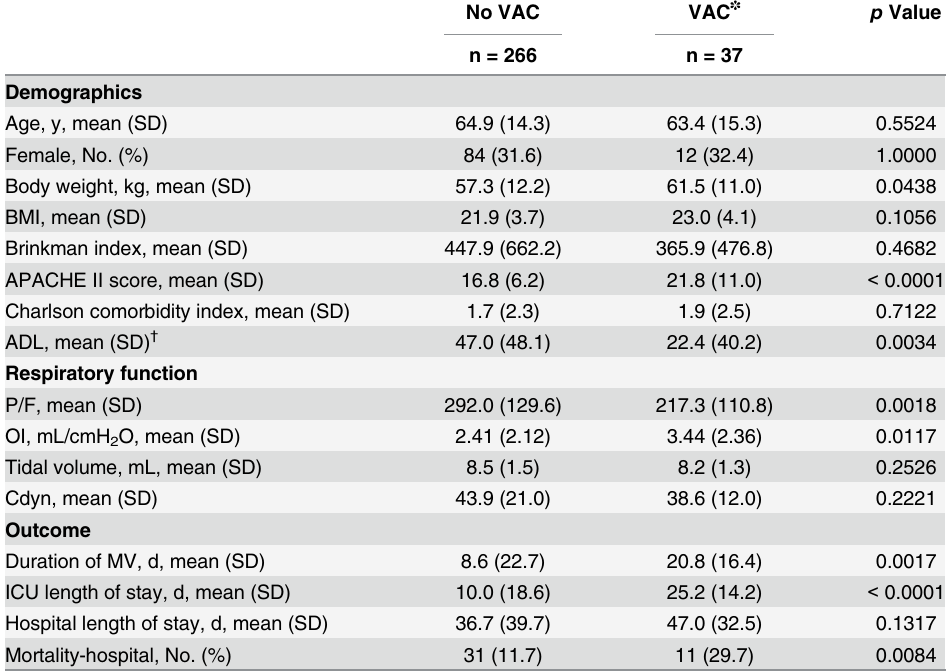
Table 1. Baseline demographics and